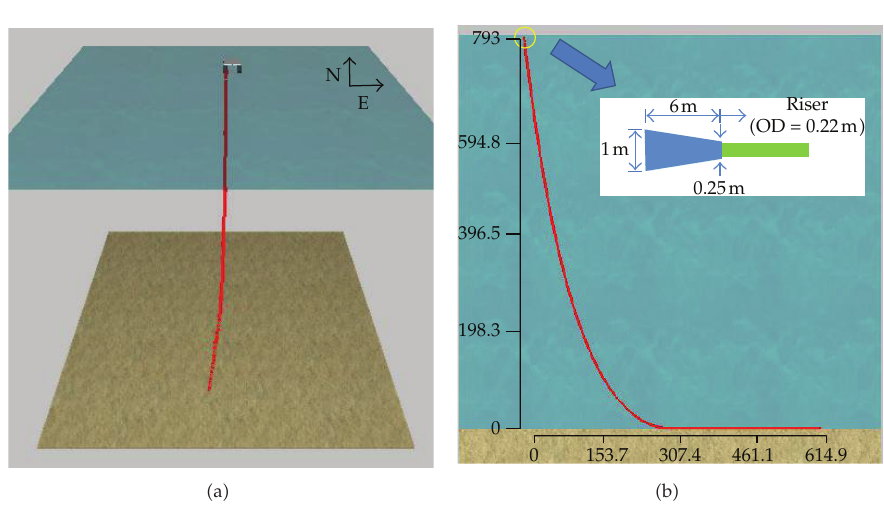
Figure 6: General overview of the studied flexible pipe: (cid:3) a (cid:4) perspective and (cid:3) b (cid:4) lateral